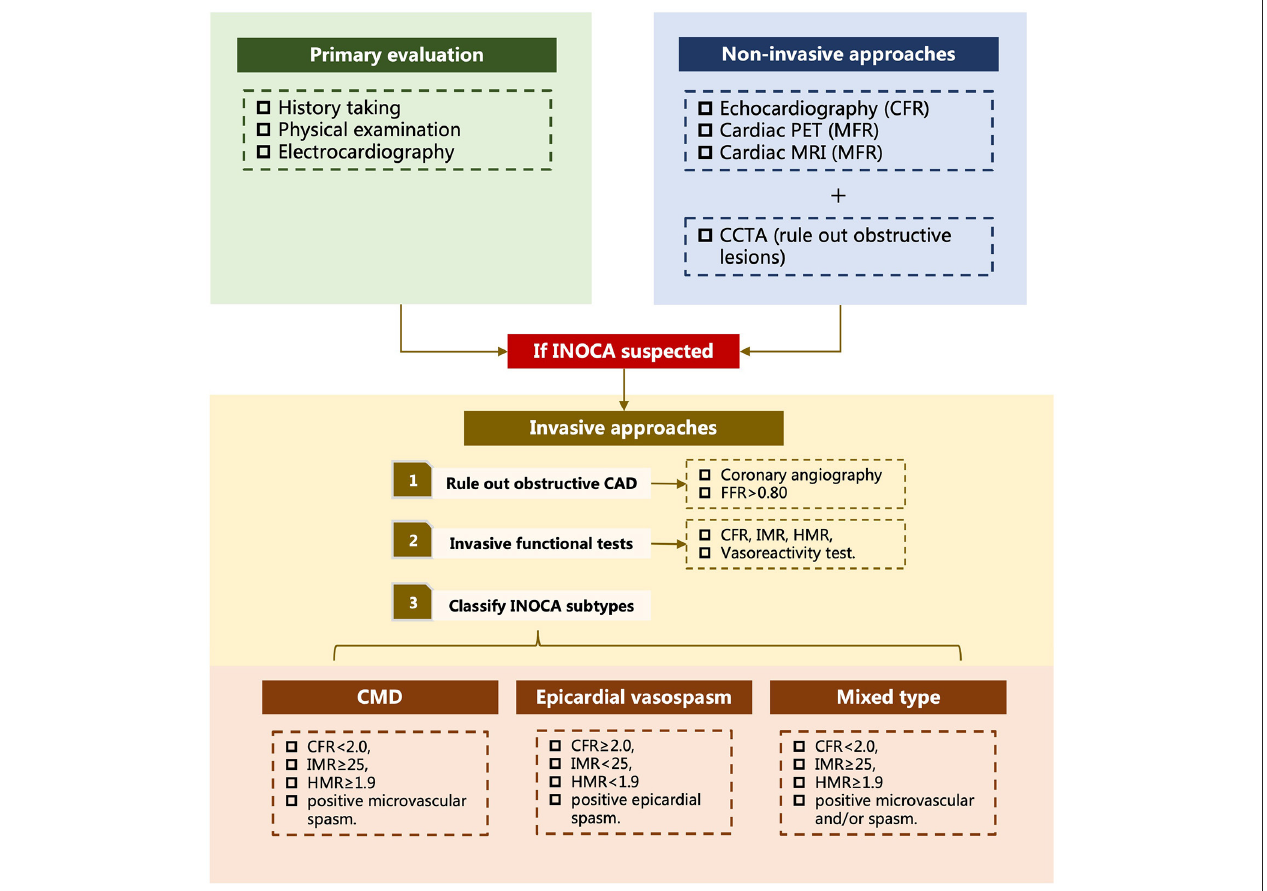
FIGURE 6 | Diagram for the evaluation of INOCA. INOCA, ischemia with non-obstructive arteries; PET, positron emission tomography; MRI, magnetic resonance imaging; CCTA, coronary computed tomography angiography; CFR, coronary flow reserve; MFR, myocardial flow reserve; CAD, coronary artery disease; FFR, fractional flow reserve; IMR, index of microcirculatory resistance; HMR, hyperemic myocardial velocity resistance; CMD, coronary microvascular dysfunction. Mixed type refers to combination of coronary microvascular dysfunction and epicardial